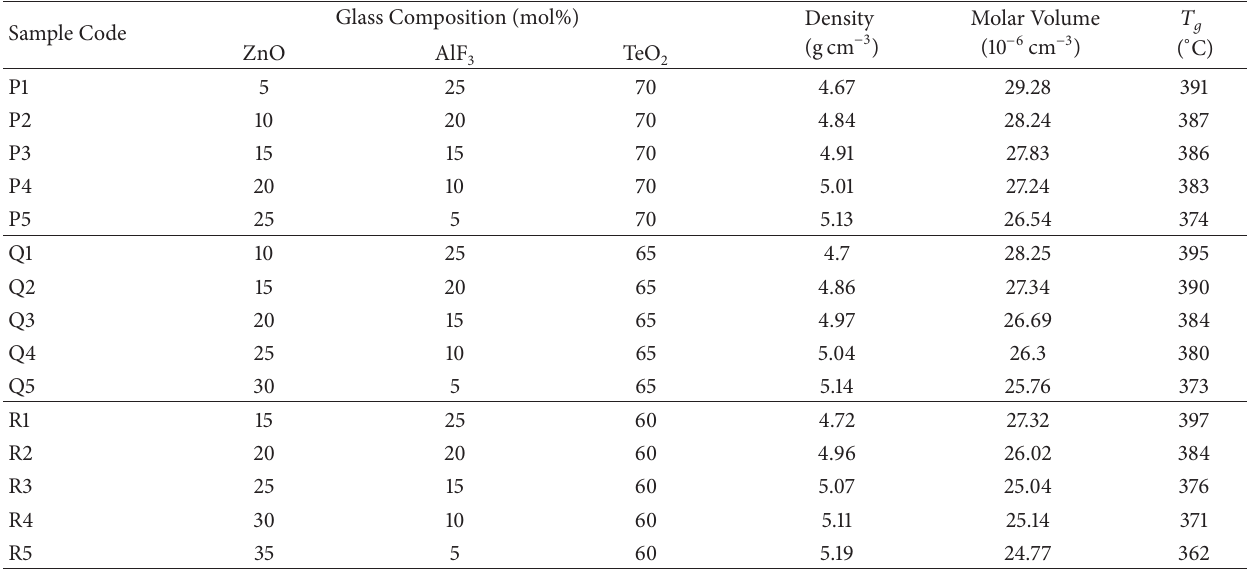
Table 1: Starting composition bulk density, molar volume, glass transition temperature ( 𝑇 𝑔 ), and molecular weight of ZOFT ( AlF ) ( TeO ) ( ZnO ) 𝑥 𝑧 glass systems at room 𝑦 3 2